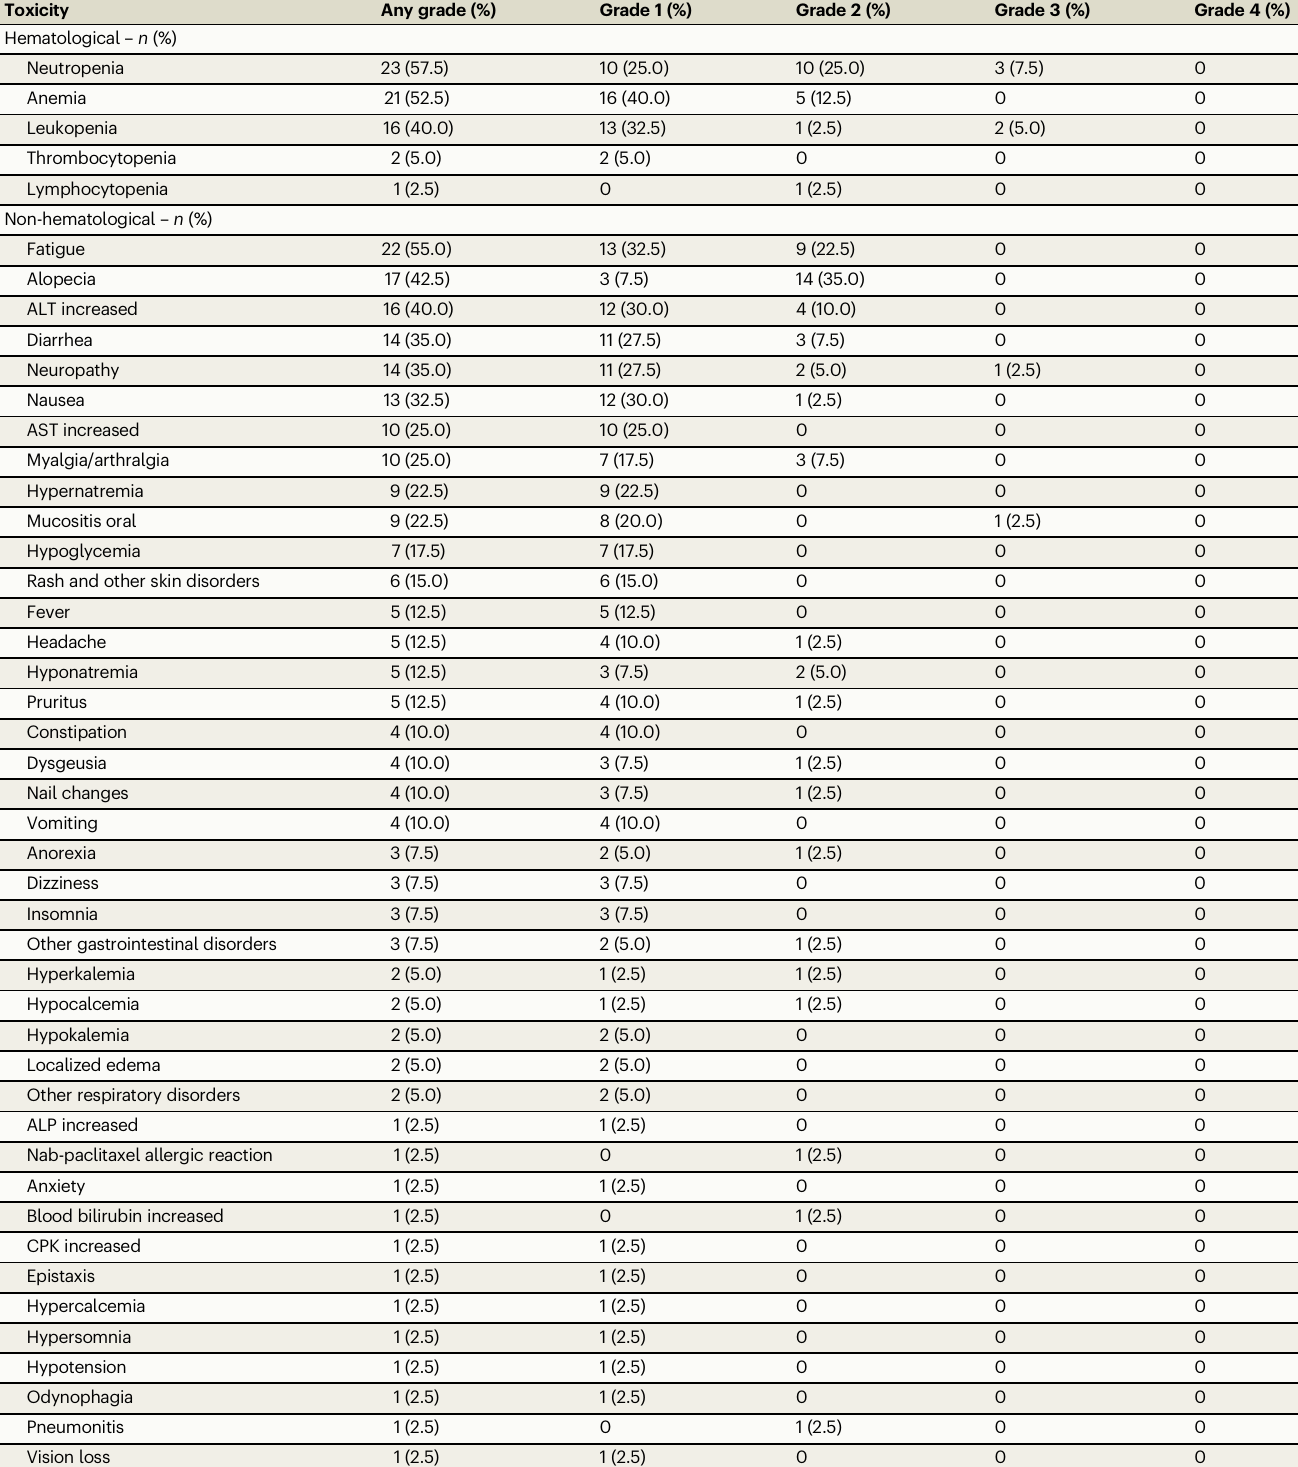
Table 2 | Toxicity pro fi le ( n =